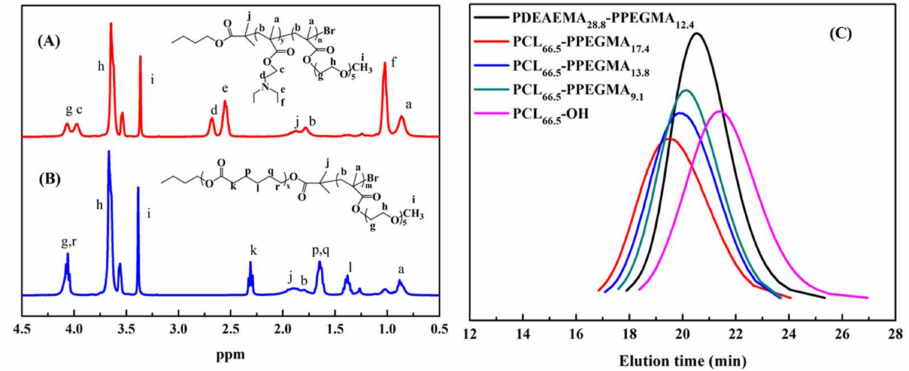
Figure 1. 1 H NMR spectra of PDEAEMA-PPEGMA ( A ) and PCL-PPEGMA ( B ) in CDCl 3 ; gel permeation chromatographic (GPC) traces ( C ) of PDEAEMA-PPEGMA, PCL-PPEGMA, and PCL-OH.